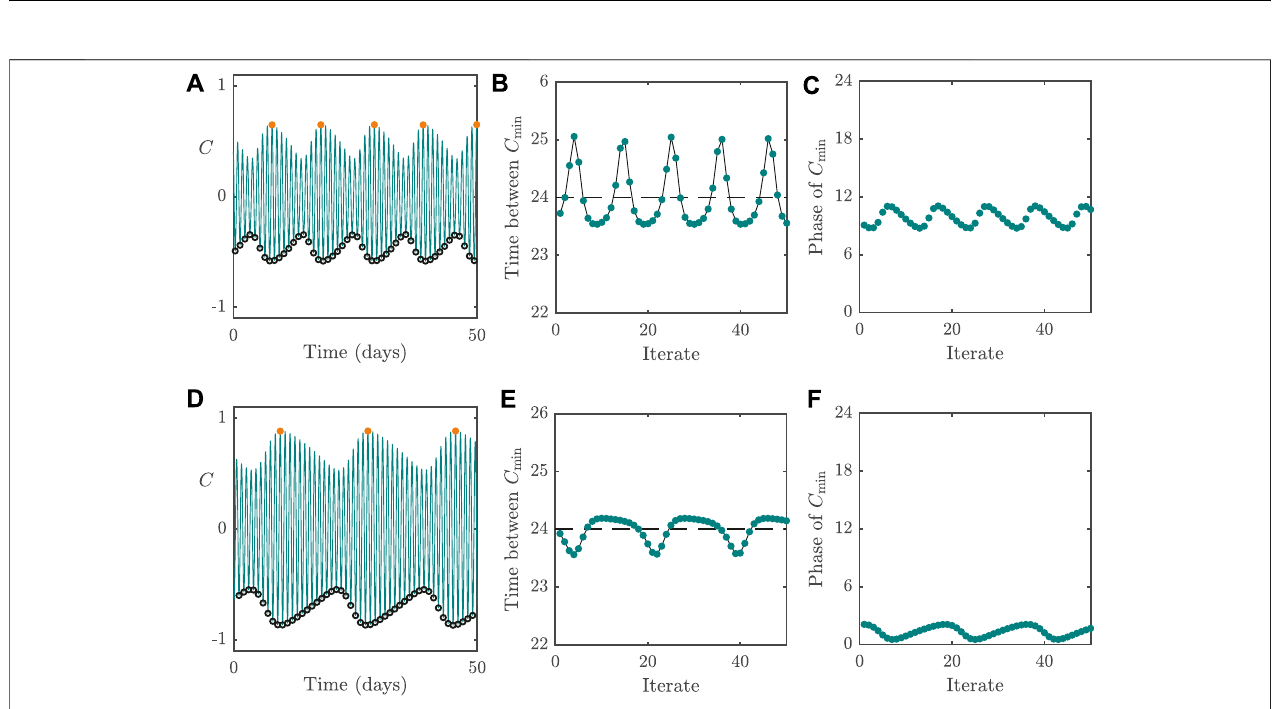
FIGURE 6 | Dynamics of the 2D model with I (cid:1) 1000 at τ c values just beyond the Neimark – Sacker bifurcation points with τ c (cid:1) 21 . 8 < τ N1 c [panels ( A – C) ] and τ (cid:1) 26 . 1 > τ N2 – F) ]. (A) + (D) : Trajectories of C highlighting modulation in the amplitude of the circadian oscillations. Open black circles indicate the daily C c c [panels (D values,andsolidorangecirclesindicatethepeakvaluesof C forthelongertimescaleamplitudemodulationwhichhasaperiod of ∼ 11 daysinpanel (A) and ∼ 18 days in panel (D) . The remaining panels are organised in the same manner as in Figure 5 .